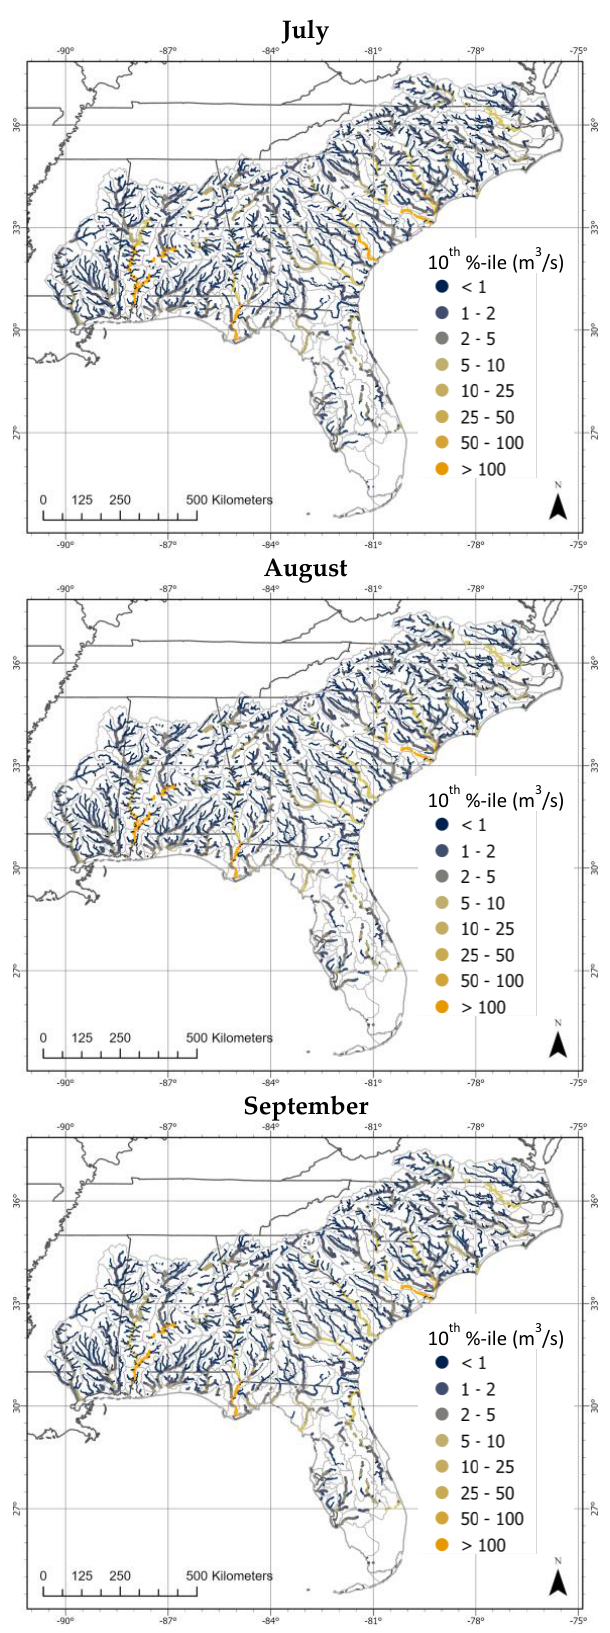
Figure 5. Warm season (July – September) patterns of 10th percentile threshold (m 3 /s) over the study region based on NWM retrospective simulations.